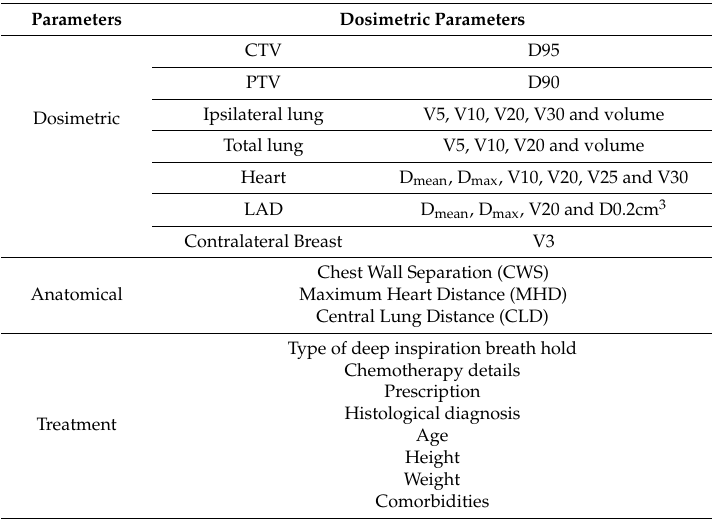
Table 2. Summary of patient data